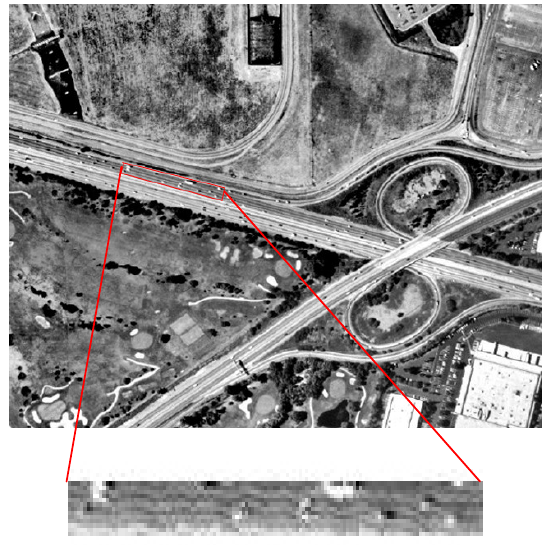
Figure21: IKONOS Panchromatic Image (1m) & ROI